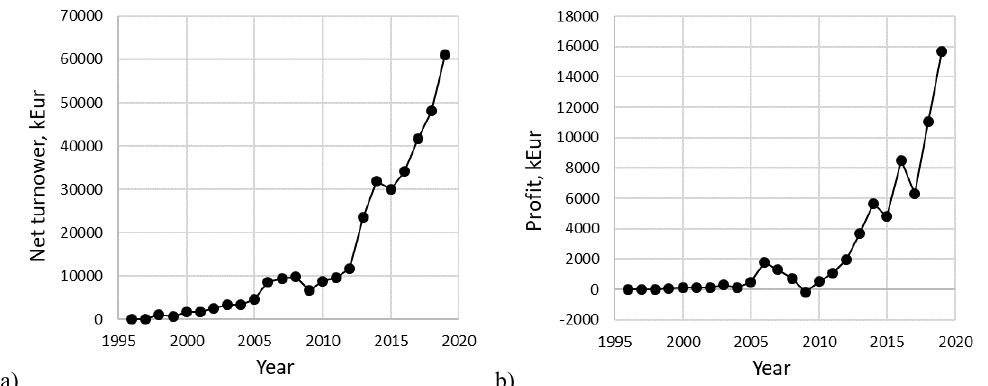
Fig. 6. Turnover (a) and profit (b) of the MD sector in Latvia, 1996–2019 (the author’s